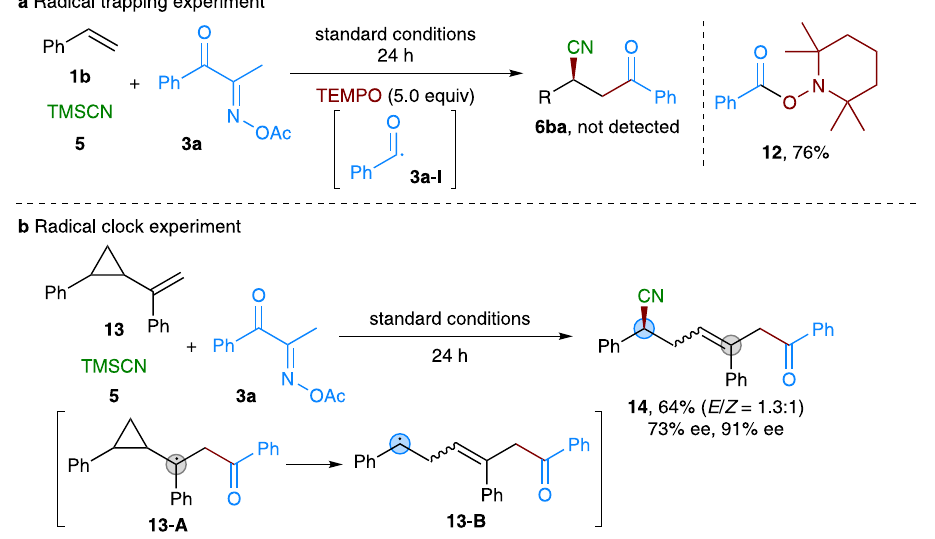
Fig. 7 Mechanistic studies. a Radical trapping experiment. b Radical clock